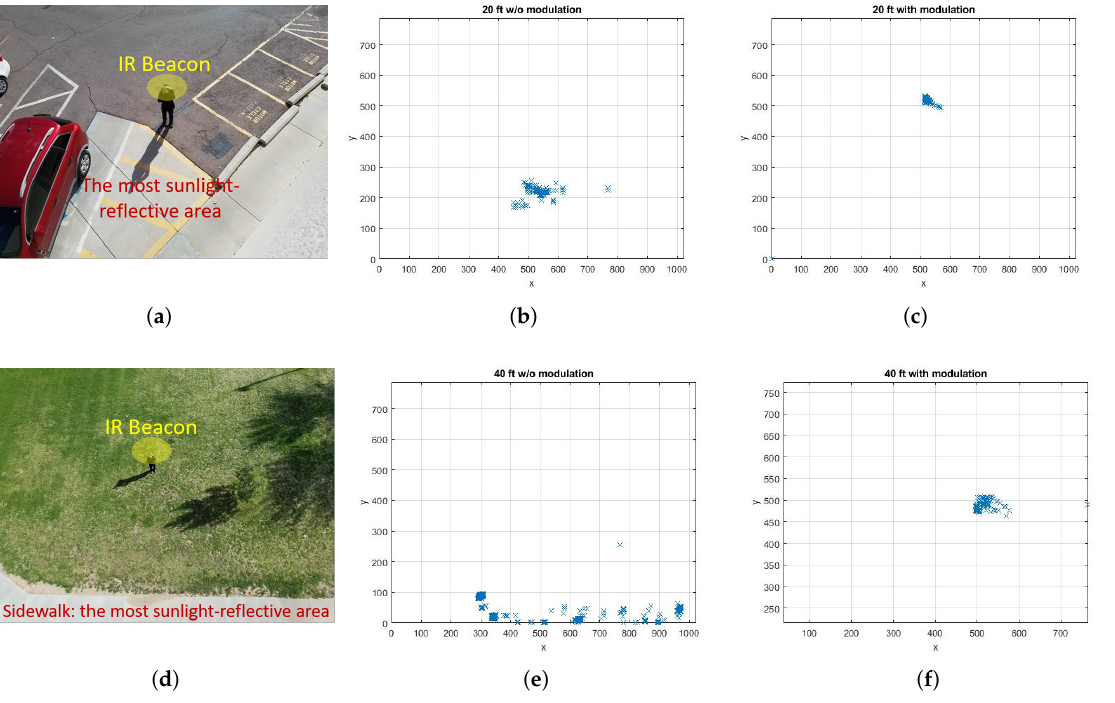
Figure 10. Signal modulation test result for 6.1 m (20 ft) ( a – c ), and 12.2 m (40 ft) ( d – f ). In the case of ( b ) and ( e ), the IR beacon was not placed on the test area. The test results for ( c ) and ( f ) indicate the location of the IR beacon with the signal modulation. ( a ) Testing area–6.1 m (20 ft) height; ( b ) Sunlight reflections at 6.1 m (20 ft) height; ( c ) IR beacon location at 6.1 m (20 ft) height; ( d ) Testing area–12.2 m (40 ft) height; ( e ) Sunlight reflections at 12.2 m (40 ft) height; ( f ) IR beacon location at 12.2 m (40 ft)